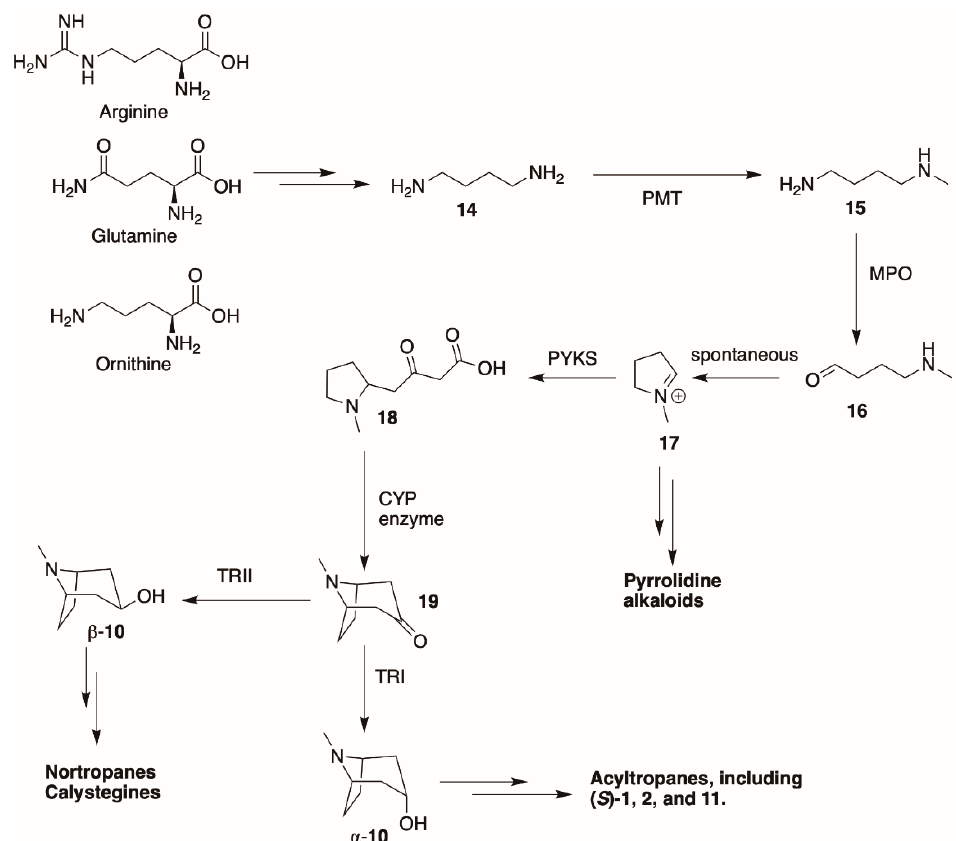
Figure 6. Biosynthesis of tropane and pyrrolidine alkaloids in Datura .